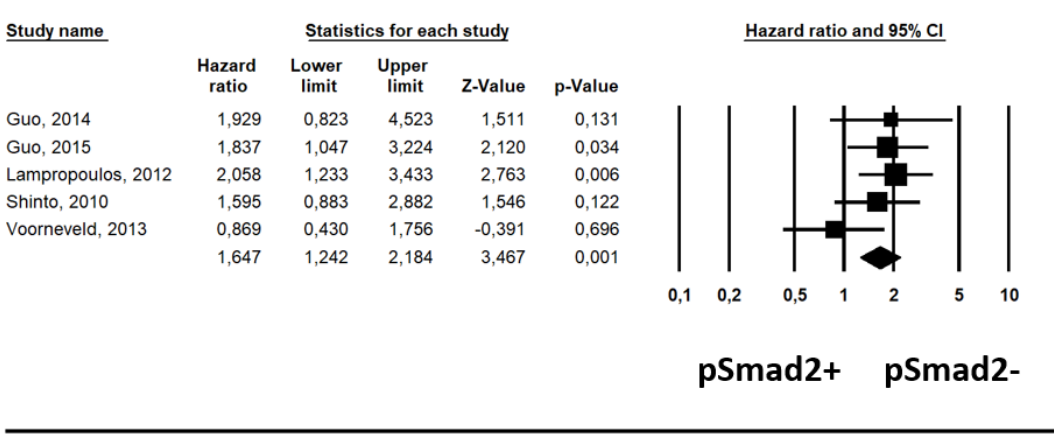
Figure 3. Forest-plot of adjusted risk of all-cause mortality: patients with pSmad2- have an increased risk of all-cause mortality, statistically significant after adjusting for potential confounders ( p = 0.001).